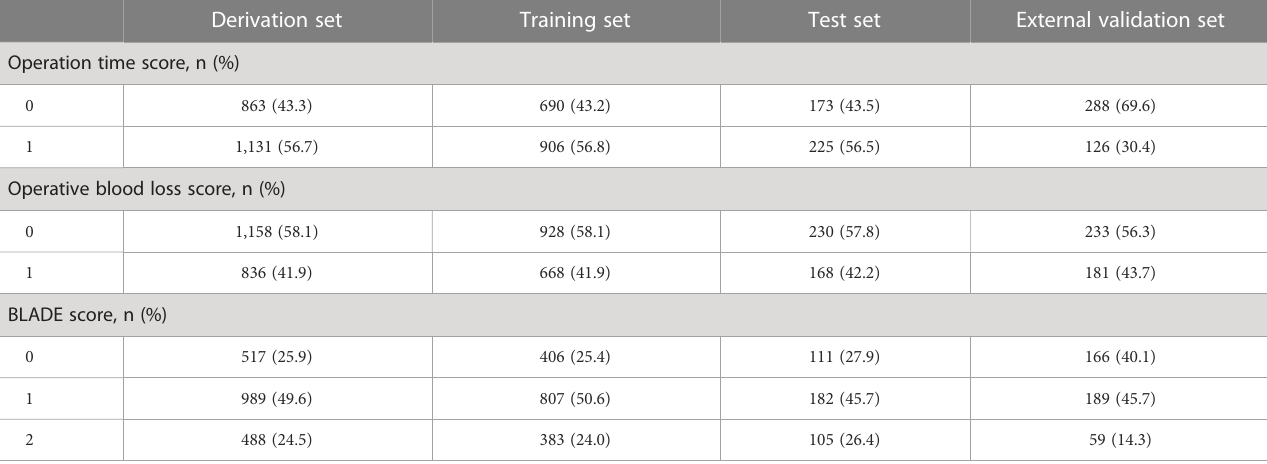
TABLE 2 Patient proportion of surgical dif fi culty for tLAR according to BLADE scoring